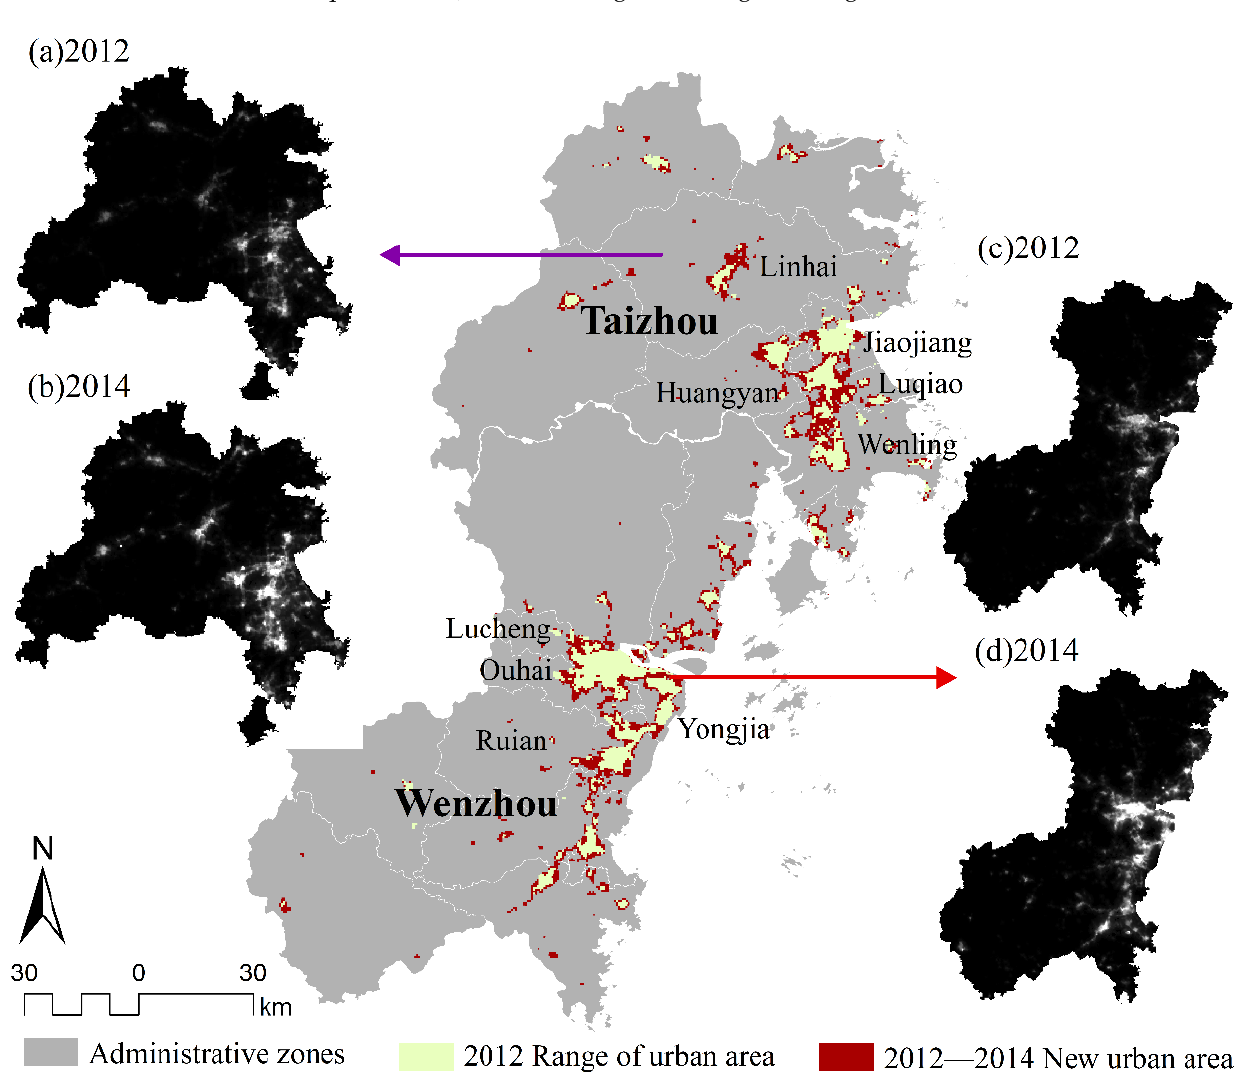
Figure 7. Nighttime light growth trends in Wenzhou and Taizhou from 2012 to 2014. From 2014 to 2020, Jiaxing, located in the northern part of Zhejiang Province, under- went a significant increase in nighttime lights. Jiaxing exhibited a 27,400 increment from 2014–2016 and a 224,188 increment from 2014–2016. According to Figure 8a, the new urban areas in Jiaxing mainly grew in an enclosed area outside the periphery of the original urban areas after 2016. Jiashan, Xiuzhou, Nanhu and Pinghu exhibited significant increments. Jiaxing is located in the northern part of Zhejiang Province and is one of the cities belonging to the Yangtze River Delta city cluster. The northeastern part of Jiaxing is located close to Shanghai, the leading city of the Yangtze River Delta, so the cities in the northern part of Jiaxing are growing relatively